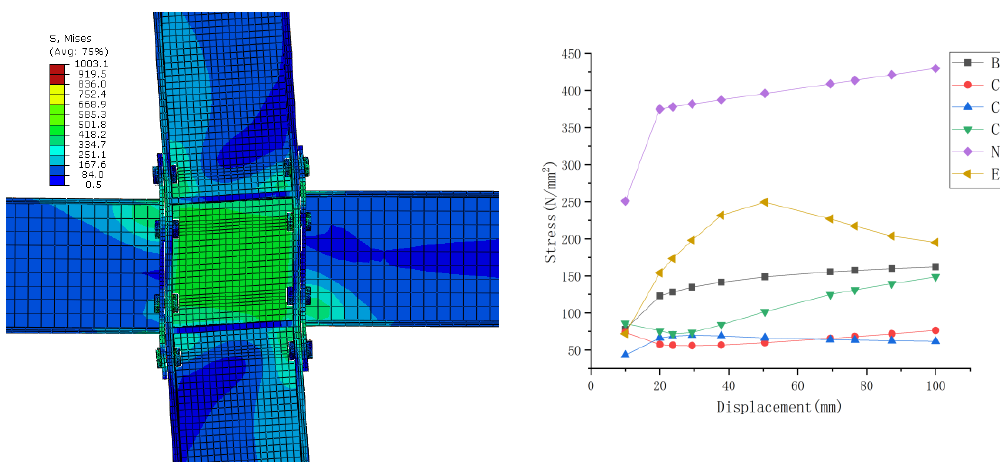
Figure 10. Stress distribution and stress history at specified points of a 6-mm end-plate.